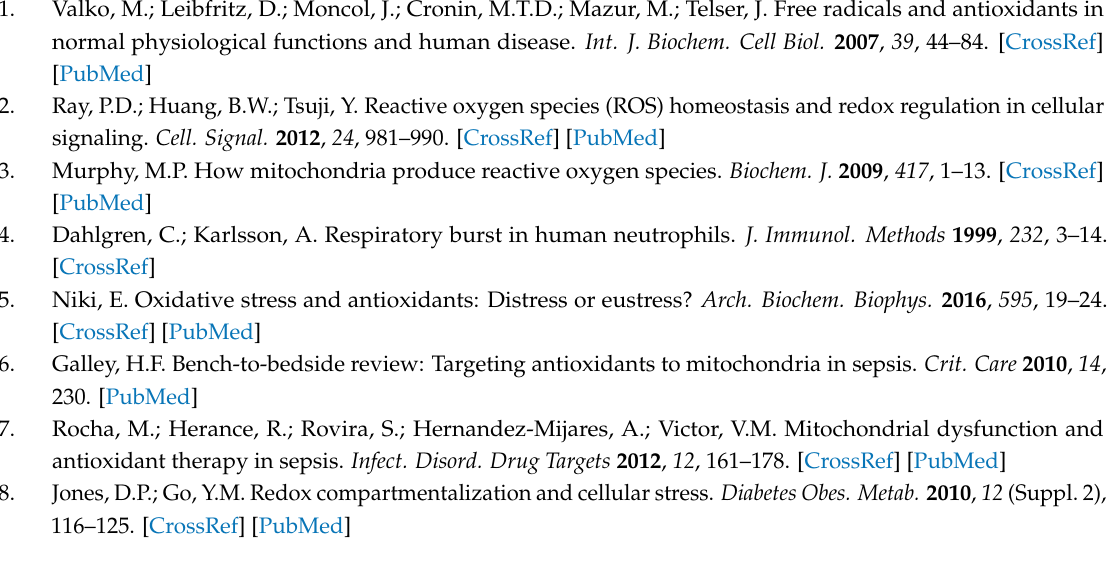
Figure S1: Mass spectrometry of thiolated oligomers, Figure S2: SEM of thiolated HEDA/CA nanoparticles at high concentration (4 mg/mL) forming a film at droplet boundary, and particle characteristics, Figure S3: Particle conjugation with